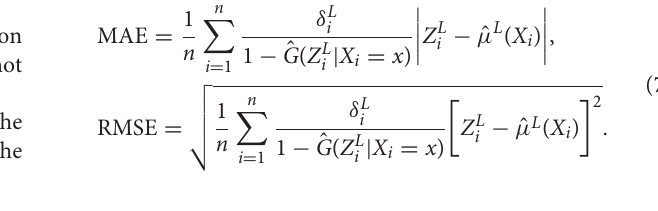
TABLE 4 | Comparison of Mean-Absolute-Error (MAE) and Rooted-Mean-Squared-Error (RMSE) for Model 2 with different link functions and the censoring distribution is mis-specificed with α = 0.5. p SRF Naive.Cox Naive.km Lu.id Lu.exp Wang.id